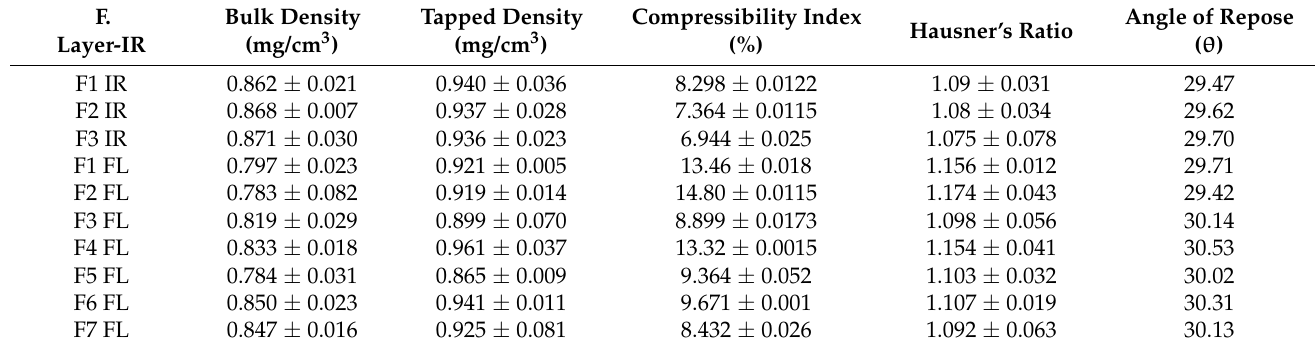
Table 1. Instant-release layer (F1 IR-F3 IR) of pantoprazole and sustained-release layer (F1 FL-F7 FL) of clarithromycin flow characteristics.